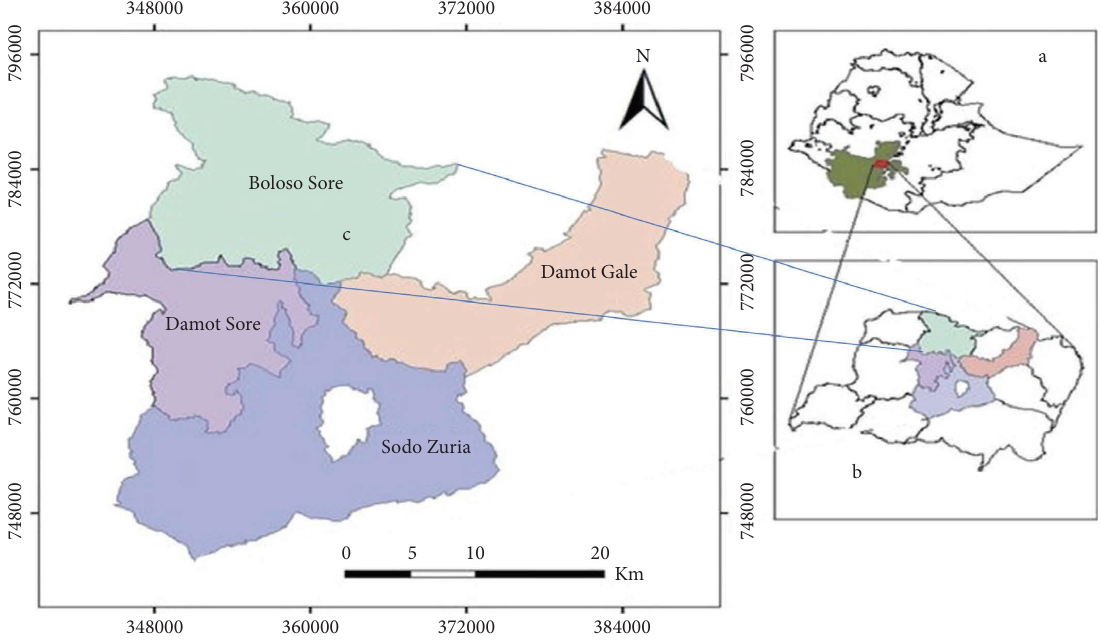
Figure 1: Map of the study area Ethiopia (a), Wolaita Zone (b), and Boloso Sore district